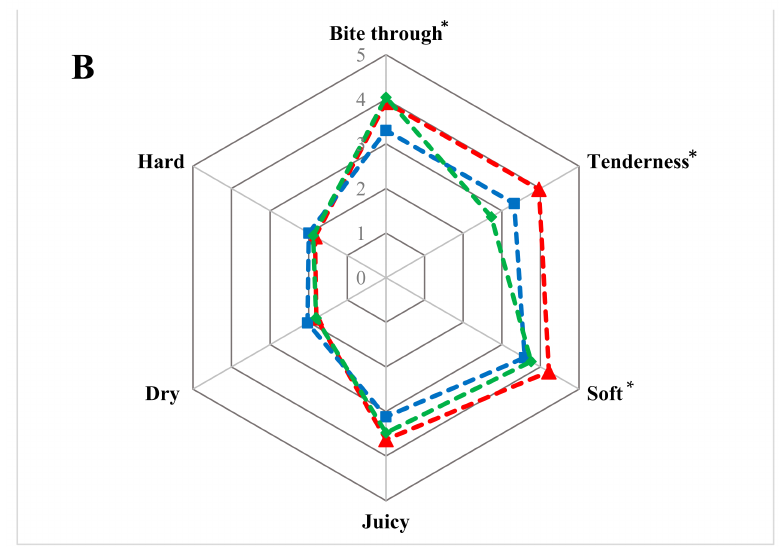
Figure 1. Taste ( A ) and texture ( B ) profiles of dry-cured leg ( n = 4) produced from lamb fed three different finishing diets (Control diet = CD, Seaweed supplemented diet = SD, Pasture diet = PD). Labelled attributes (*) showed significant difference ( p < 0.05).